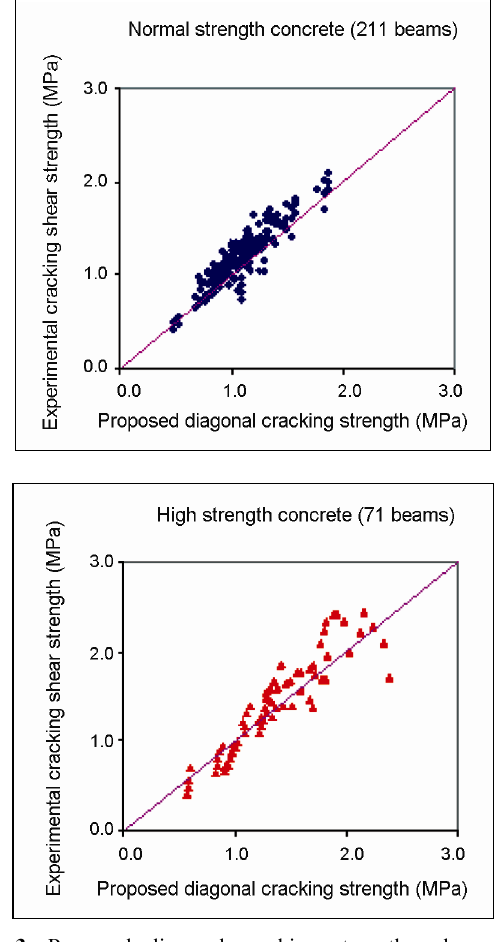
Fig. 3. Proposed diagonal cracking strength values using Eq. (12) versus experimental cracking shear strength values